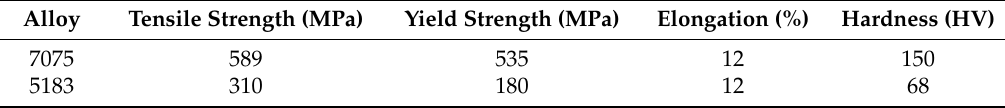
Table 1. Mechanical properties of 7075 aluminum alloy and ER5183 welding